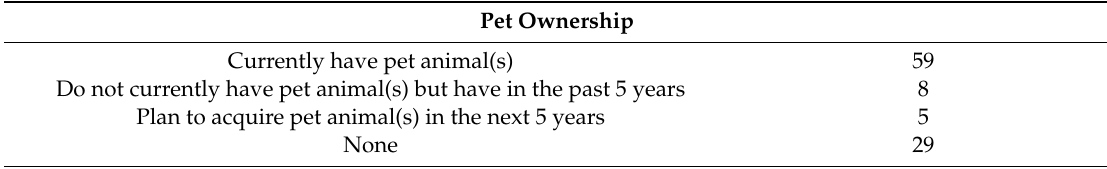
Table 2. Pet ownership statistics (n = 1000), percent (%) of